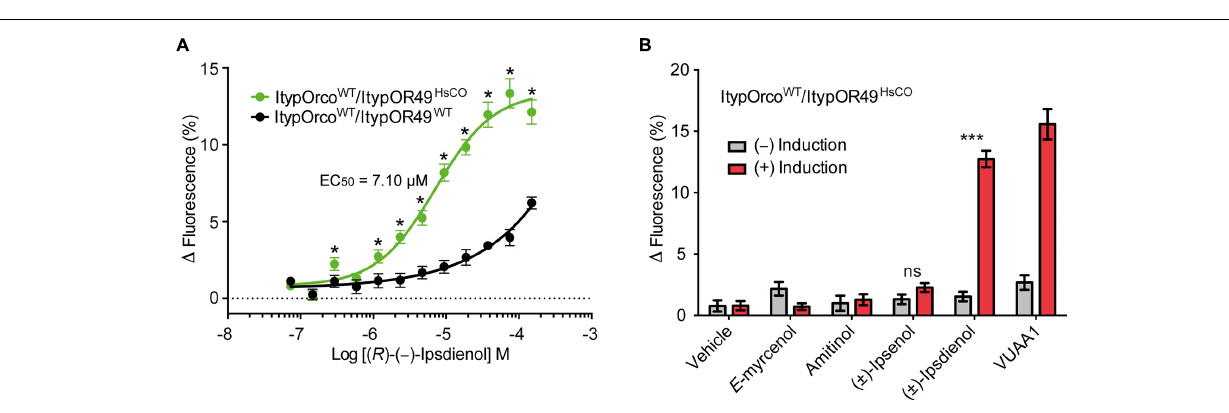
FIGURE 3 | Response of cells co-expressing wildtype (WT) I. typographus Orco (ItypOrco WT ) and wildtype or codon optimized (HsCO) ItypOR49. (A) Dose-dependent responses of ItypOR49 WT and ItypOR49 HsCO to main ligand ( R )-( − )-ipsdienol with higher responses of cells expressing the codon optimized gene ( n = 4 biological replicates; n total = 12). Asterisks (*) indicate significantly higher responses in ItypOR49 HsCO as compared to ItypOR49 WT ( p = 0.042 to < 0.001). The EC 50 value for ItypOR49 WT was not calculated due to non-sigmoid dose-response curve. (B) Screening results (30 µ M compound concentration) from cells co-expressing ItypOrco WT and ItypOR49 HsCO showing the same specificity as previously reported for ItypOR49 WT (Yuvaraj et al., 2021) ( n = 4 biological replicates; n total = 12). Asterisks (***) indicate significantly higher response in induced (+) versus non-induced ( − ) cells at p < 0.001. Error bars show